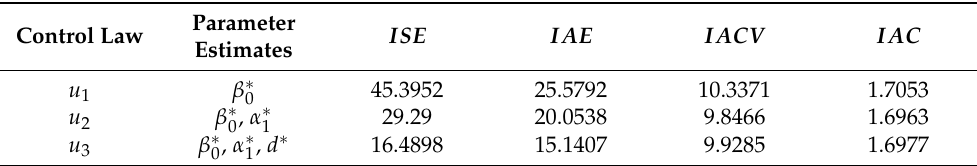
Table 9. Performance indexes using the LSOD method and white noise as an excitation signal using the control laws